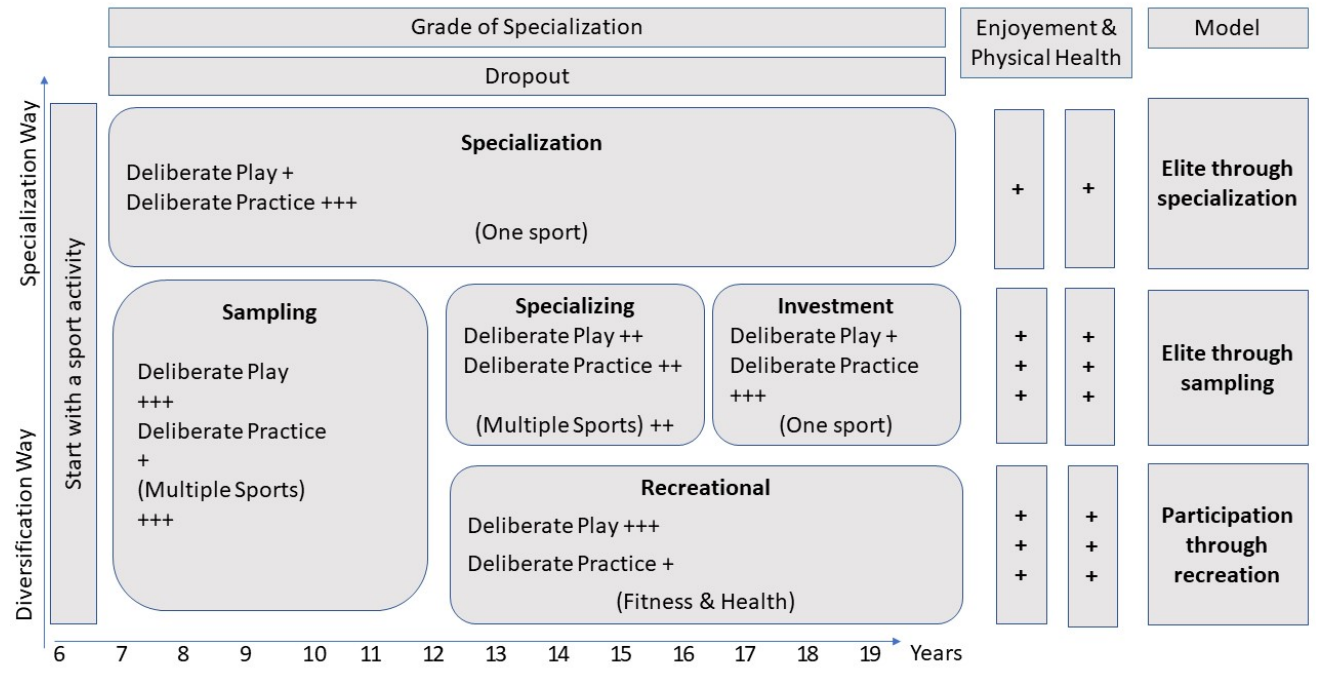
Figure 1. Developmental Model of Sport Participation (Reprinted with permission from Côtè & Frasher-Thomas, 2007)).